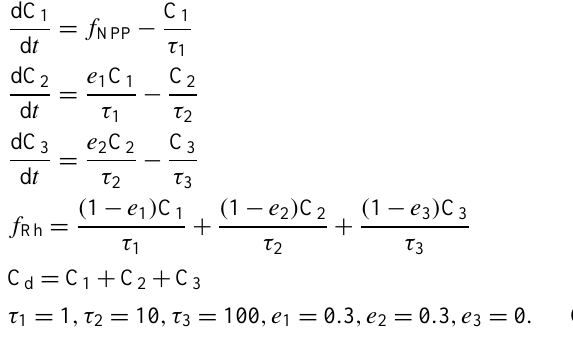
Figure 10. Responses of linearized equilibrium dead carbon pools (kgCm − 2 over the interval of CO 2 doubling) in biogeochemically coupled (esmFixClim1) run. Left column shows productivity-driven changes to c C d . Right column shows turnover-driven changes to c C d